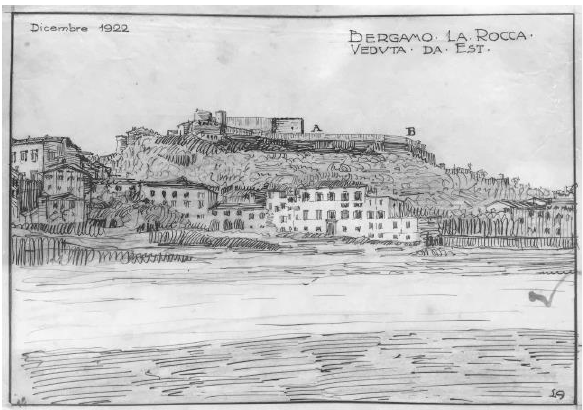
Figure 1. The Parco della Fara by Luigi Angelini